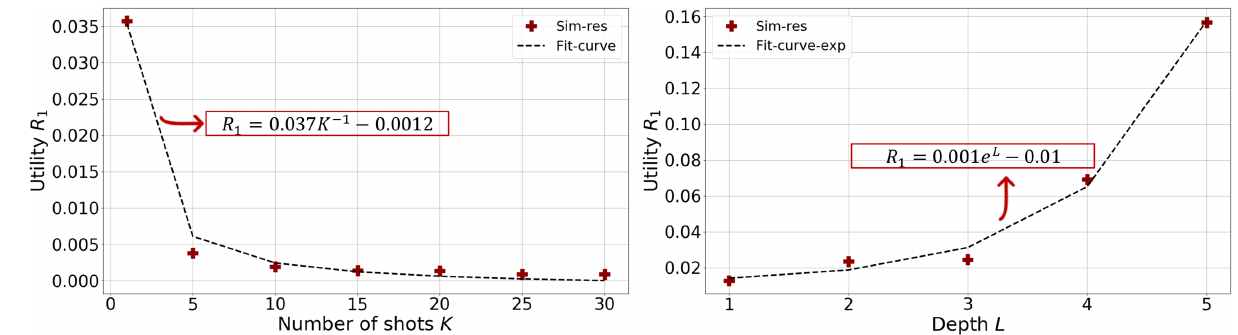
FIG. 5. The left panel depicts how the utility R 1 scales with the number of shots K . The label “Sim-res” refers to the collected simulation results with the varied settings. The label “Fit-curve” refers to the fitting curve, i.e., the mathematical form is aK − 1 + b with a , b ∈ R , with respect to the collected results. The right panel depicts how the utility R 1 scales with L . The label “Sim-res” has the same meaning as the left panel. The label “Fit-curve-exp” refers to the fitting curve for the exponential function, i.e., the mathematical form is ae K + b with a , b ∈ R , with respect to the collected